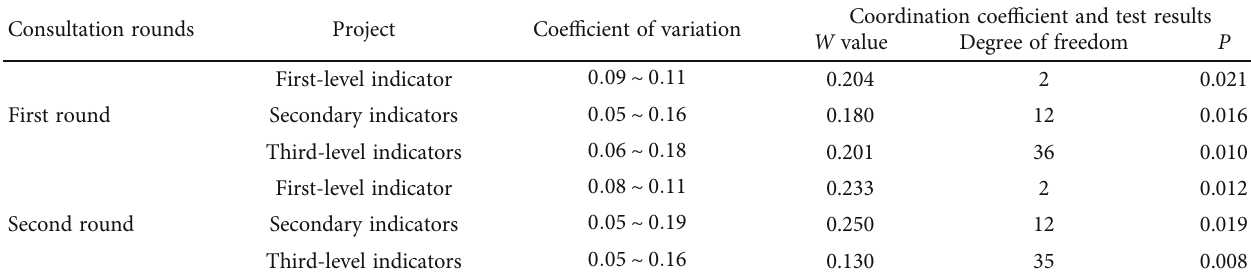
Table 1: Degree of coordination and its signi fi cance test